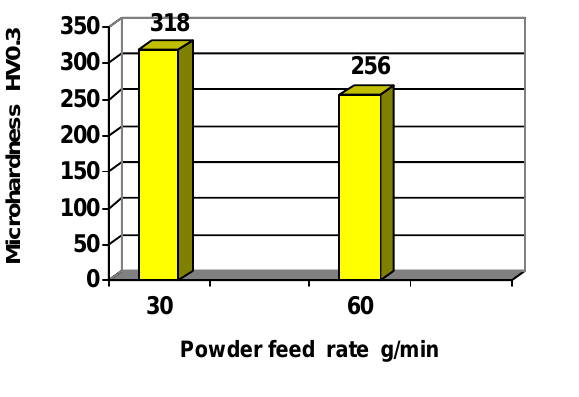
Figure 3 – Microhardness of Ni5,5wt.%Al5wt.%Mo layers Рис . 3 – Микротвердость Ni5,5 вес .%Al5 вес .%Mo слоев Слика 3 – Микротврдоћа Ni5,5 теж .%Al5 теж .%Mo